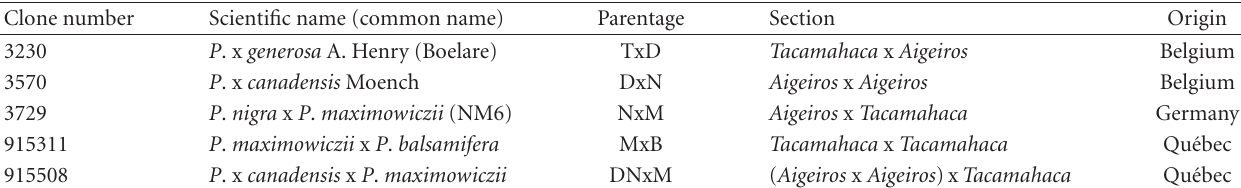
Table 2: Name, parentage, section, and origin of the five hybrid poplar